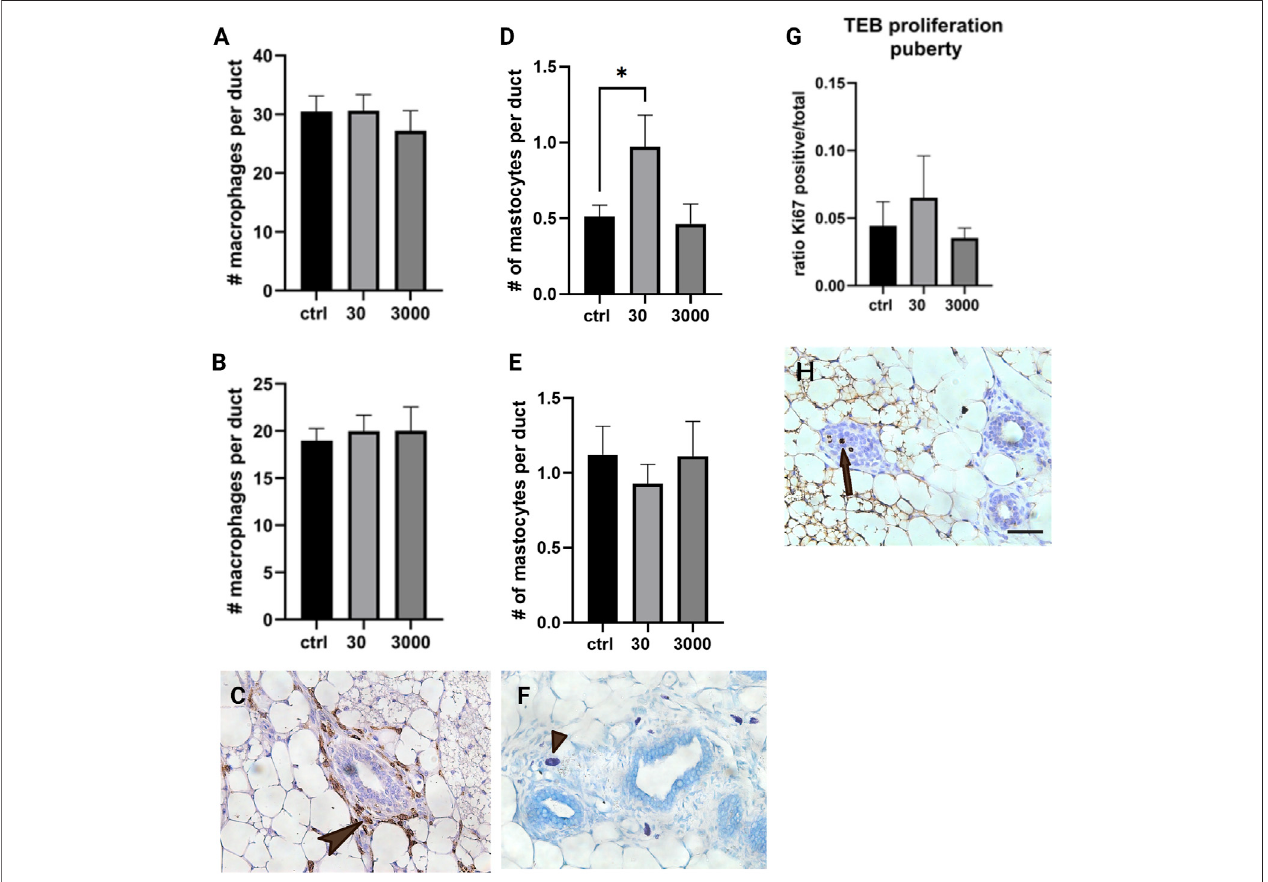
FIGURE 5 | Effect of oxybenzone on macrophages, mast cells, and proliferation in TEBs. (A) Number of macrophages in the periductal stroma at puberty. (B) Number of macrophages in the periductal stroma in adulthood. (C) Immunohistochemistry for F4/80, a marker of macrophages. This image illustrates macrophages localized in the mammary periductal stroma (arrowhead). (D) Number of mast cells in periductal stroma at puberty. (E) Number of mast cells in periductal stroma in adulthood. (F) Toluidinebluestaining,highlightingmastcellsinthemammarystroma(stainingpurple,arrowtip). (G) RatioofKi67positivecellstototalcellsinTEBs at puberty. * indicates signi fi cance, p < 0.05, ANOVA with Tukey posthoc test. (H) Proliferation in a TEB as indicated by immunohistochemistry for Ki67 (three cells in mitosis, the arrow pointing towards the middle proliferating cell). Scale bar = 20 μ m.